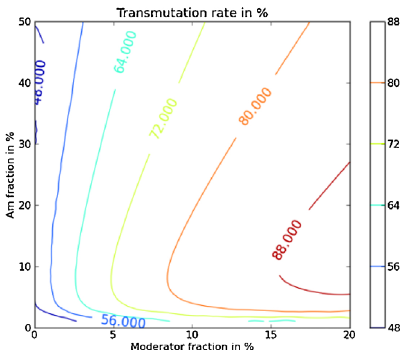
Fig. 3. Transmutation rate versus fraction of moderator.